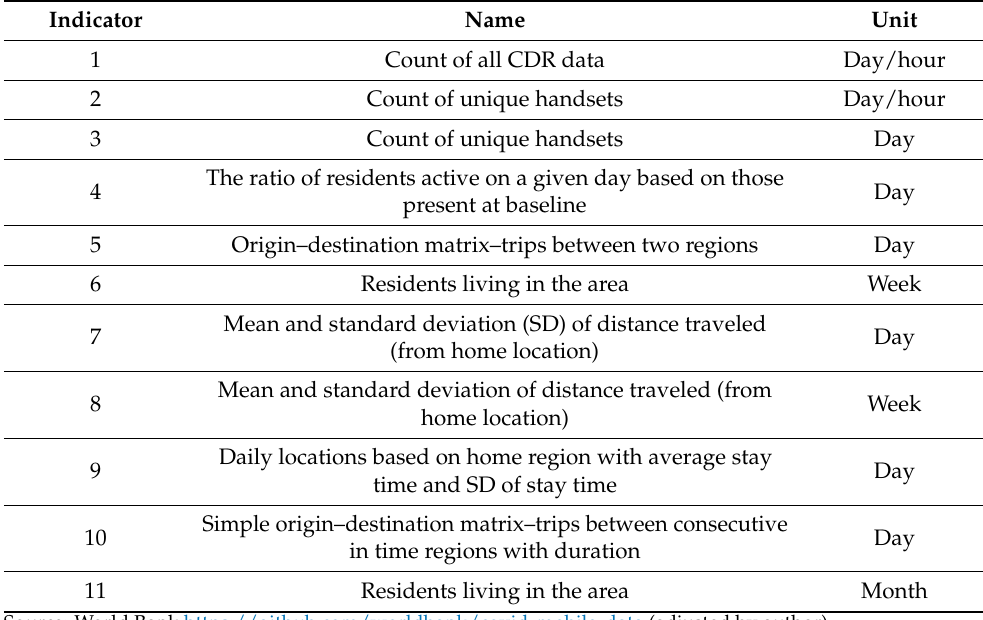
Table 5. The definition of